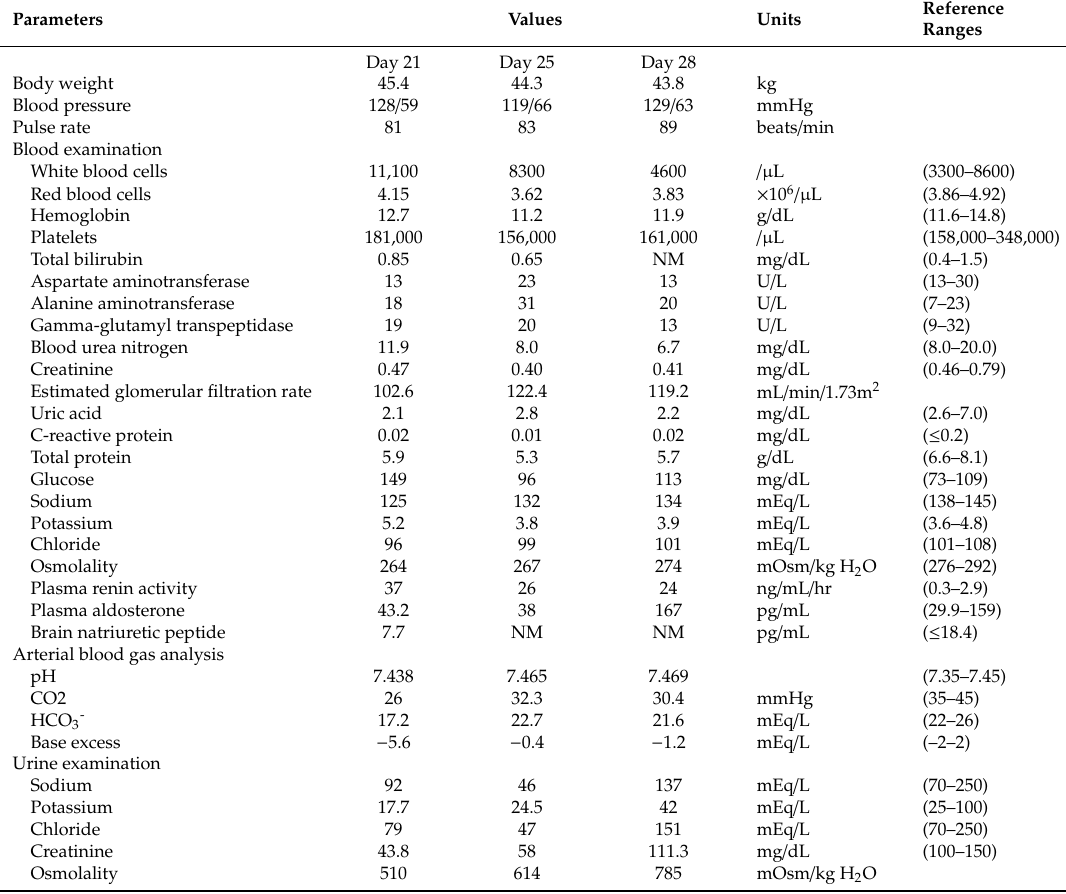
Table 2. Changes of clinical parameters just before and after trimethoprim